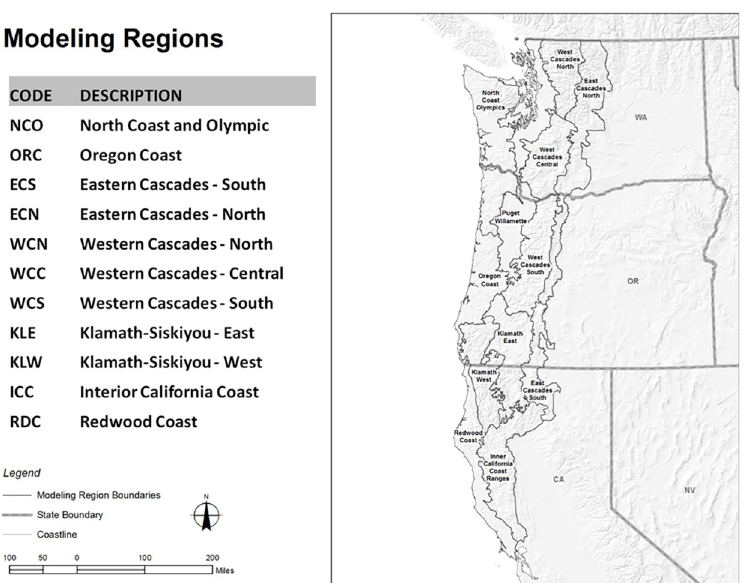
Fig 1. Geographic extent of study area and modeling regions